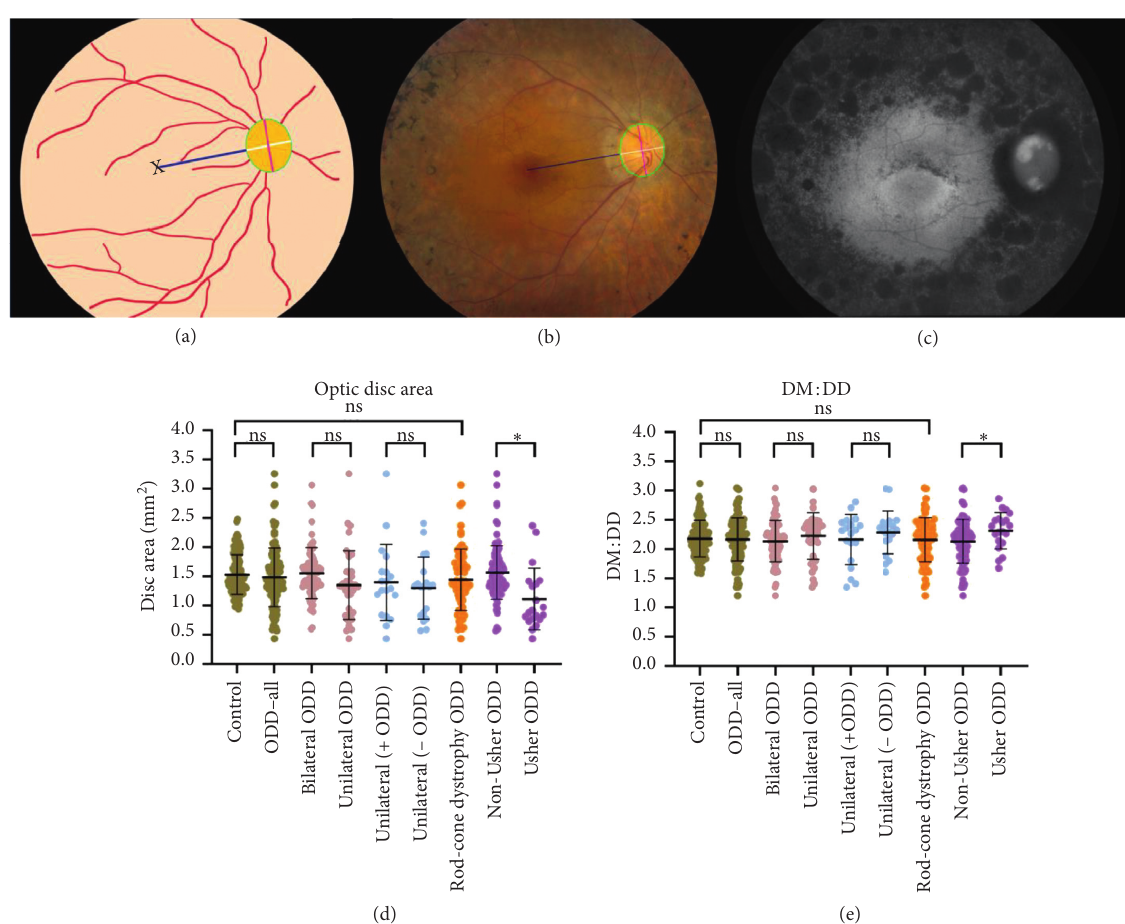
Figure 2: Optic disc parameters among the inherited retinal degeneration cohort. (a) Schematic diagram of optic disc parameters; black “x” indicates fovea centralis, taken as the macula, the navy line represents temporal edge of disc-to-macula distance, the white line indicates horizontal disc diameter, the magenta line indicates vertical disc diameter, and green circumference highlights optic disc area. Disc-to- macula distance (DM) was defined as the distance from the center of the disc to the macula, and disc diameter (DD) was defined as the average of the horizontal and vertical disc diameter. (b) Color fundus image of a patient with optic disc drusen (ODD) and retinitis pigmentosa, with measurements corresponding to schematic diagram in (a). (c) Fundus autofluorescence of the same patient with ODD and retinitis pigmentosa. Drusen are visualized as hyperautofluorescent areas on the optic disc. Box plots of (d) optic disc area and (e) DM: DD among each cohort and subgroup, with each individual data point representing one scored image. Patients with ODD and Usher syndrome had significantly smaller disc area and DM :DD than patients with ODD without Usher syndrome. ∗ P < 0 .